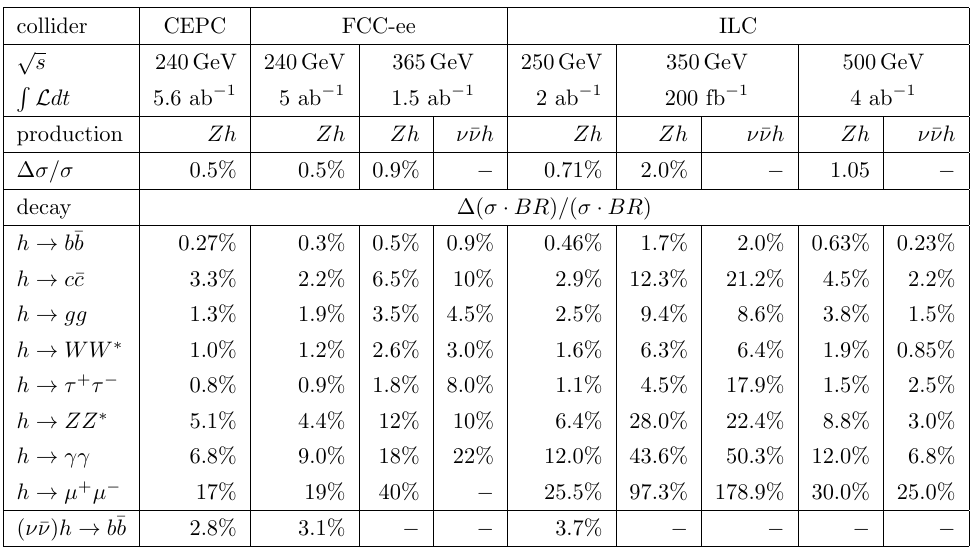
Table 3 . Estimated statistical precisions for Higgs measurements obtained at the proposed CEPC program with 5.6 ab (cid:0) 1 integrated luminosity [27, 45], Fcc-ee program with 5 ab (cid:0) 1